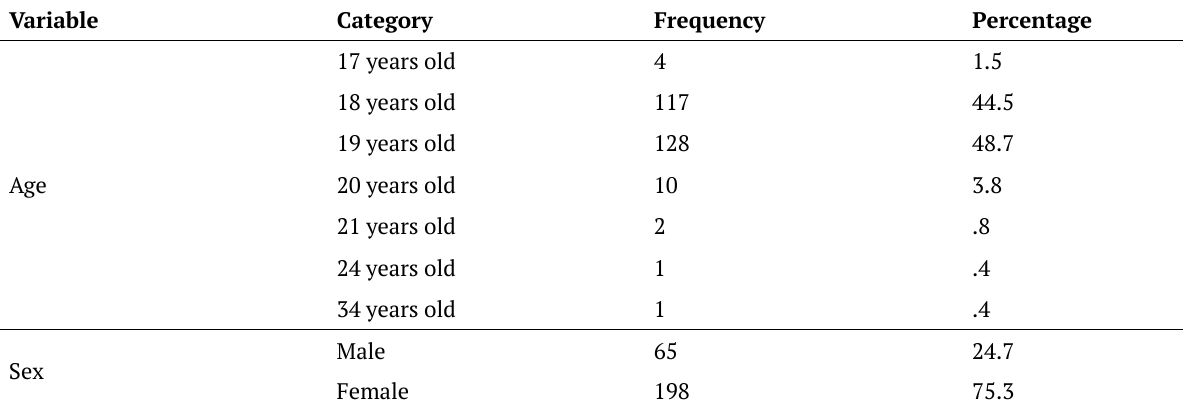
Table 1. Participants’ profile